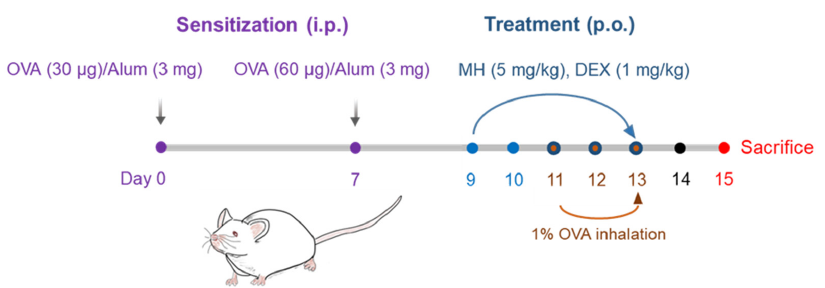
Figure 5. The establishment of the mice with AA and the administration of MH. BALB/c mice were randomly divided into four groups, sensitized with OVA/alum mixture on days 0 and 7, and exposed to OVA inhalation on days 11–13. Oral administration of MH or DEX was performed on days 9–13. On day 15, the mice were sacrificed, and the collection of BALF, serum, and lungs was performed for analysis.